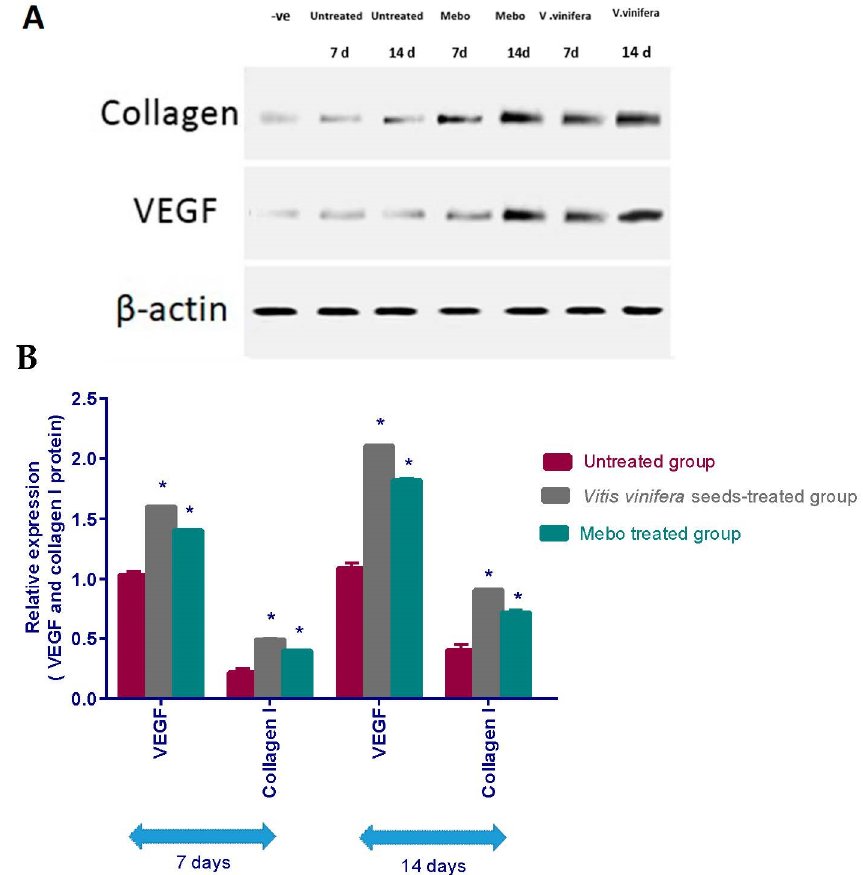
Figure 7. Effect of V. vinifera seed extract on the expression of VEGF and collagen type I proteins. ( A ) Representative immunoblotting of VEGF, collagen type I proteins, and β -actin proteins for all groups. ( B ) Densitometric expression of VEGF and collagen type I proteins was expressed as fold difference relative to normal control rabbits applying bands in (A) seeking normalization to the comparable internal control β -actin. The bars show the mean ± SD and are based on the results of three independent investigations. A one-way ANOVA test is applied to measure whether there is a significant difference between groups, where: * p < 0.001 when compared to the positive control group on a specified day, and p < 0.001 when compared on the same day to the Mebo ® group.